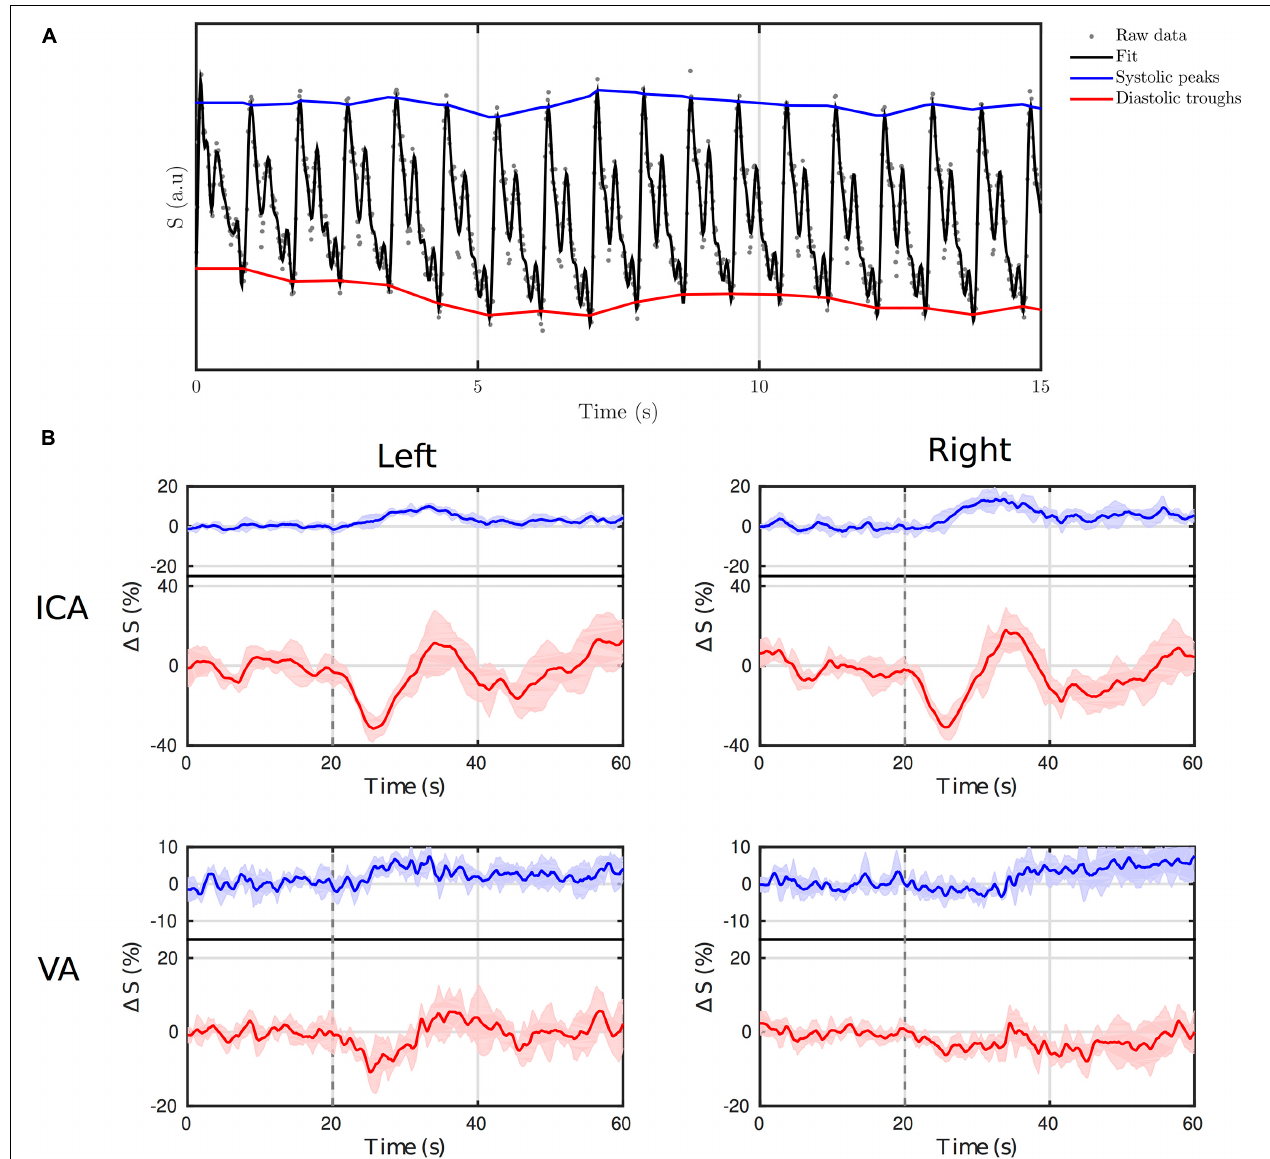
FIGURE 7 | (A) First 15 s of the TCR-challenge time series taken from the left ICA ROI. (B) The systolic (blue) and diastolic (red) time series (i.e., signal envelope) averaged across the five repeats, for both ICA and VA bilaterally. The onset of the thigh-cuff release is highlighted with a dotted grey line. Both left and right internal carotid arteries (ICA) show clear time locked responses to the TCR-challenge in both systolic and diastolic time series. The same responses are far less evident in the VA time series, particularly in the right side.